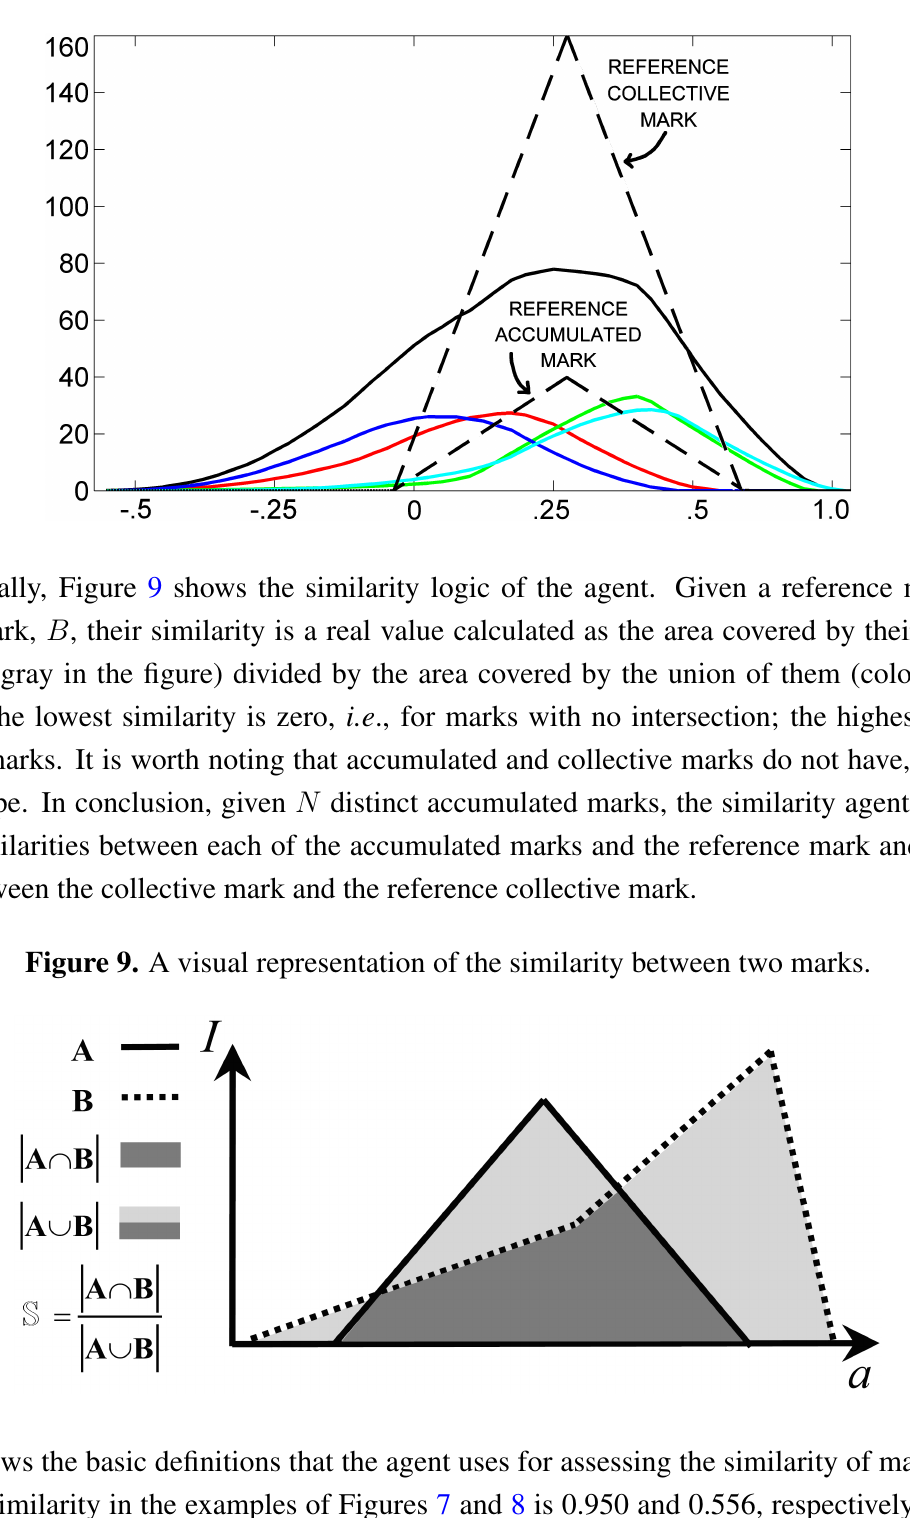
Figure 8. An example of marks produced by poorly synchronized rowing strokes (solid lines) with the reference marks (dashed lines).